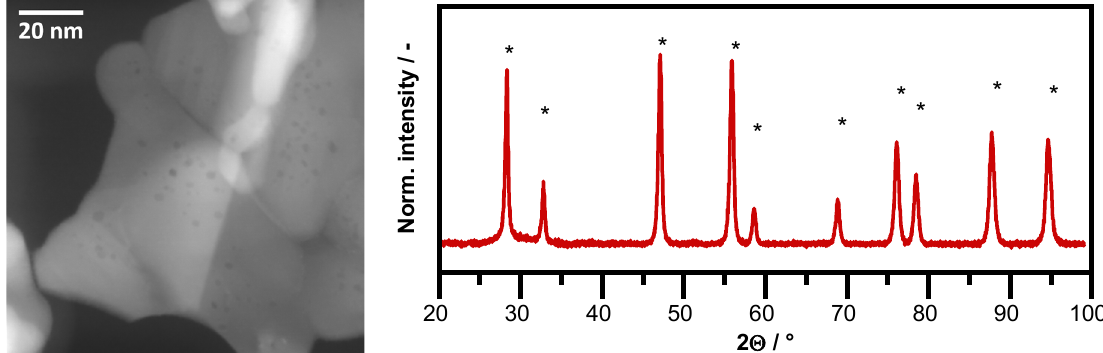
Figure 1. TEM micrograph of Pt-single site samples evidence the absence of Pt nanoparticles (left); XRD diffractogram of the sample (right). Stars indicate the reflections typical for CeO 2.